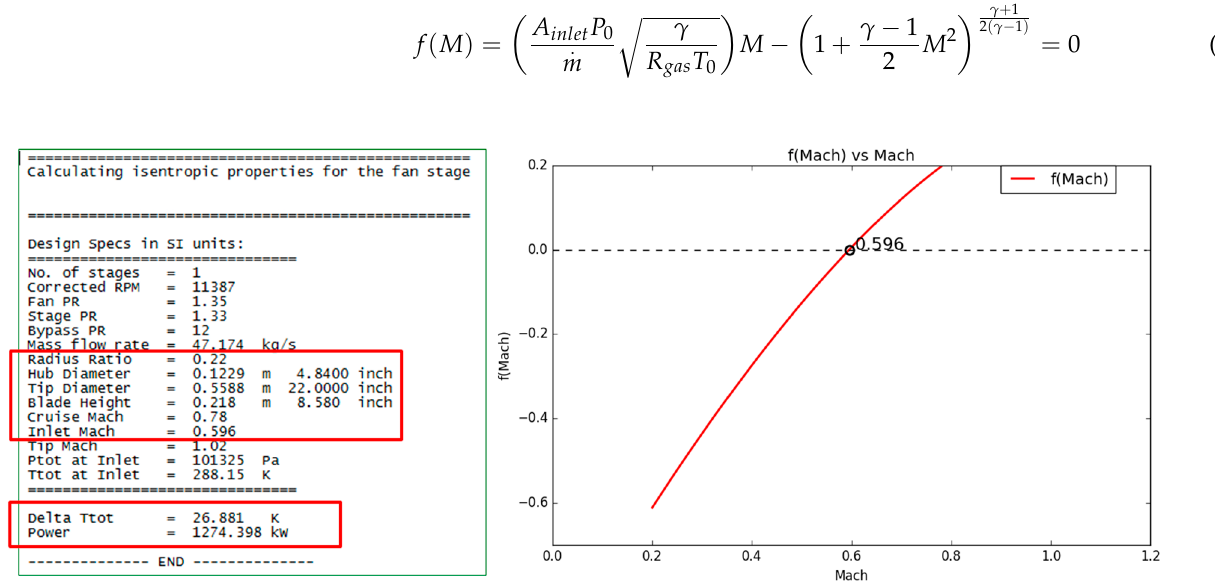
Figure 3. Machine sizing using isentropic relations from a 0D solver along with the inlet Mach number calculated by an iterative solver. An example turbofan stage calculation is shown here.